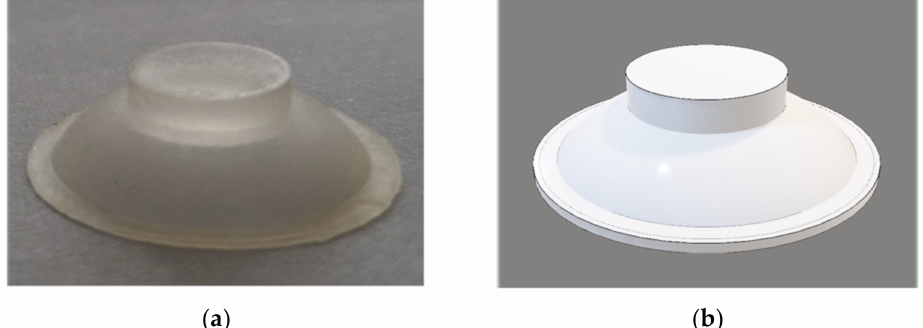
Figure 7. Fully polymeric dome: ( a ) real-life prototype; ( b ) 3D rendering implemented in COMSOL Multiphysics ®